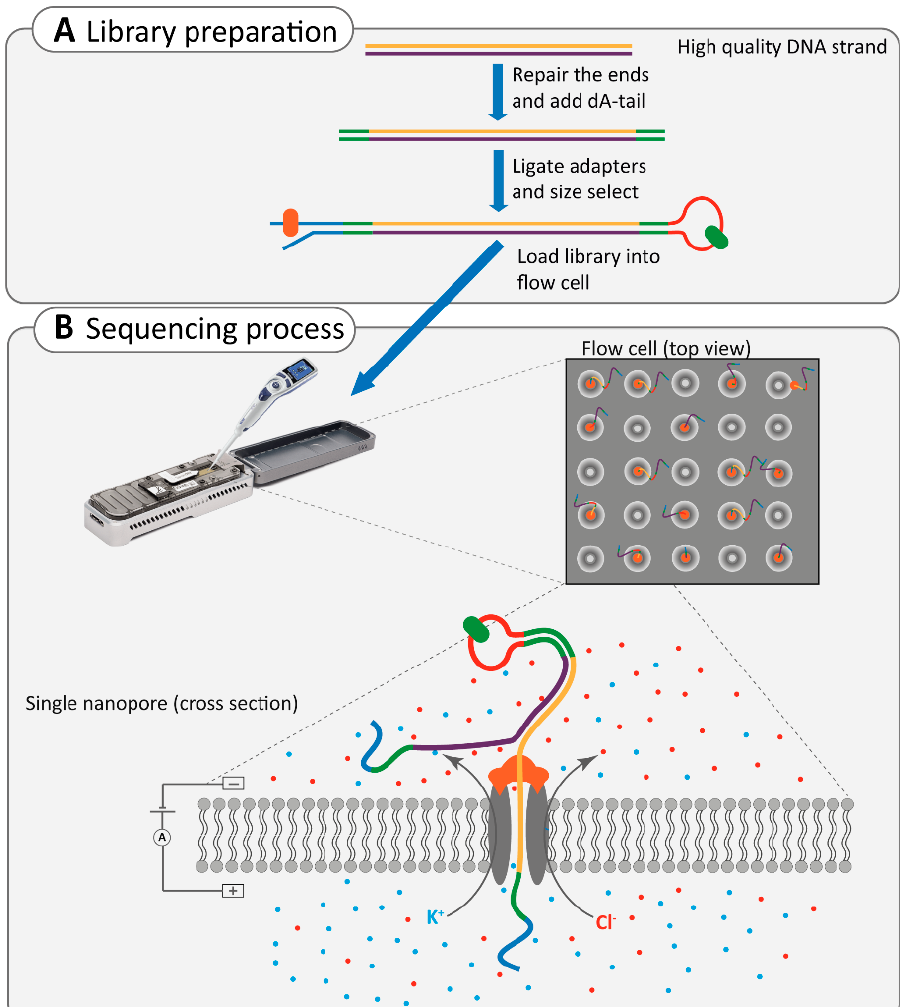
Figure 2. Overview of the Nanopore sequencing technology. ( A ) The library preparation includes end-repairing, and adding dA-tails, followed by ligation of two types of adapters to both ends of the ultra-long double-stranded DNA. The adapters carry the motor enzyme (in orange) and hairpin-protein (in green) to facilitate the movement of DNA through the nanopore and ensure the sequencing of the second strand of DNA, respectively. ( B ) The library is loaded into the flow cell in the sequencer instrument. The flow cell contains thousands of nanopores that allow the flow of Cl − and K + ions between two compartments. The motor enzyme anchors to the nanopore and unwinds the DNA to pass it through the pore. Thereby, the electric current is influenced based on the unique shape of each nucleotide in single-strand DNA. These changes in the electric current are later translated to sequences.